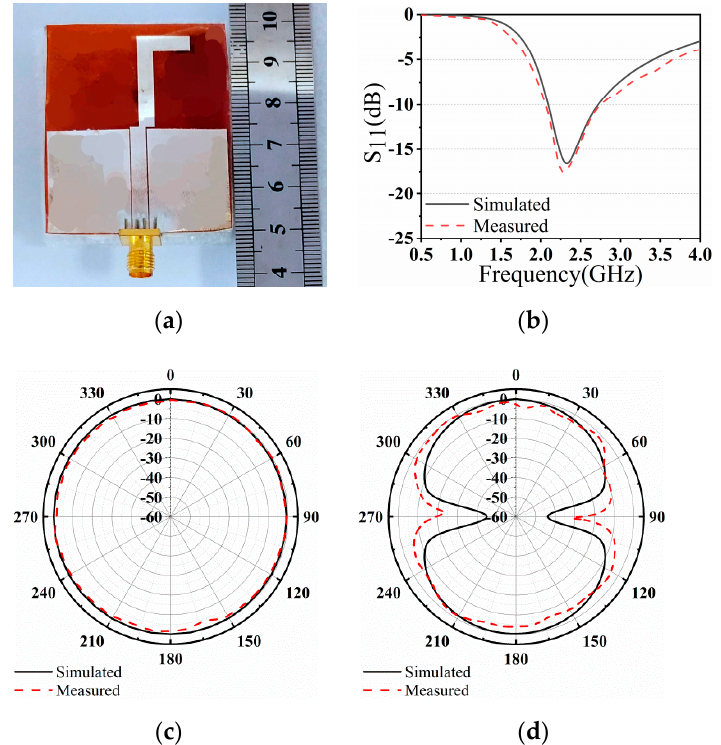
Figure 7. ( a ) Photographs of the fabricated prototype. Simulated and measured characteristics under the flat state. ( b ) Reflection coefficients. Radiation patterns: ( c ) x – z plane; ( d ) x – y plane.